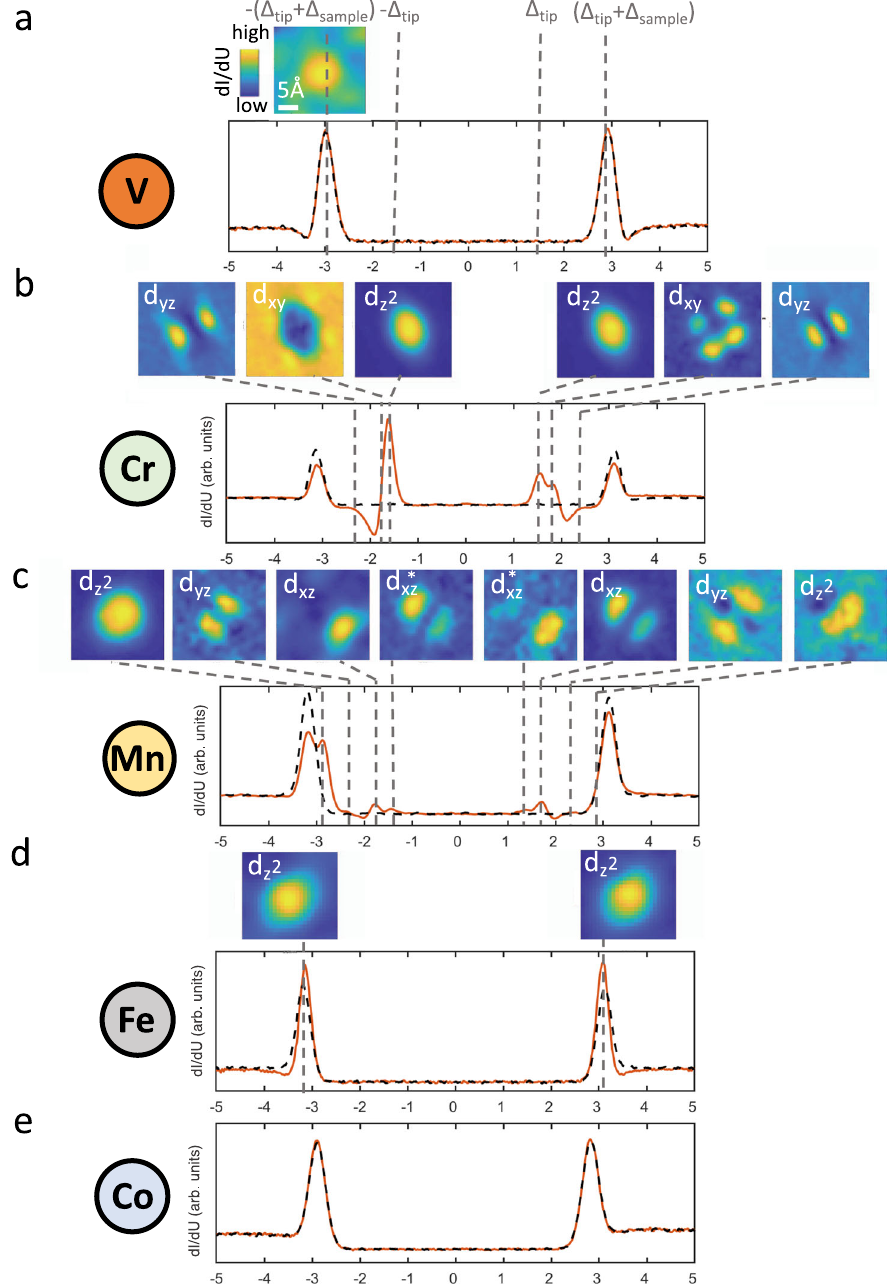
Fig. 2 Yu – Shiba – Rusinov (YSR) spectroscopy. a – e Scanning tunneling spectroscopy for V, Cr, Mn, Fe, and Co. While no YSR state is detected for V and Co, a rich set of in-gap states emerge for Cr, Mn, and Fe. The insets show the spatial distribution of the YSR states, which re fl ect their orbital character and allows one to quantify their spatial extension. Stabilization parameters: V = 5 meV, I = 500